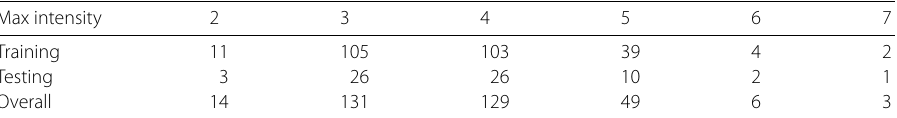
Table 4 Training/testing partition for events according to the maximum Mercalli intensity of each seismic movement. High energy events are less frequent than low energy events. Note that this table summarizes our dataset in terms of number of earthquakes, but for each of these earthquakes we have many municipality-level local instances. In fact, as high energy earthquakes cover a wider area, they produce many municipality-level instances Max intensity 2 3 4 5 6 Training